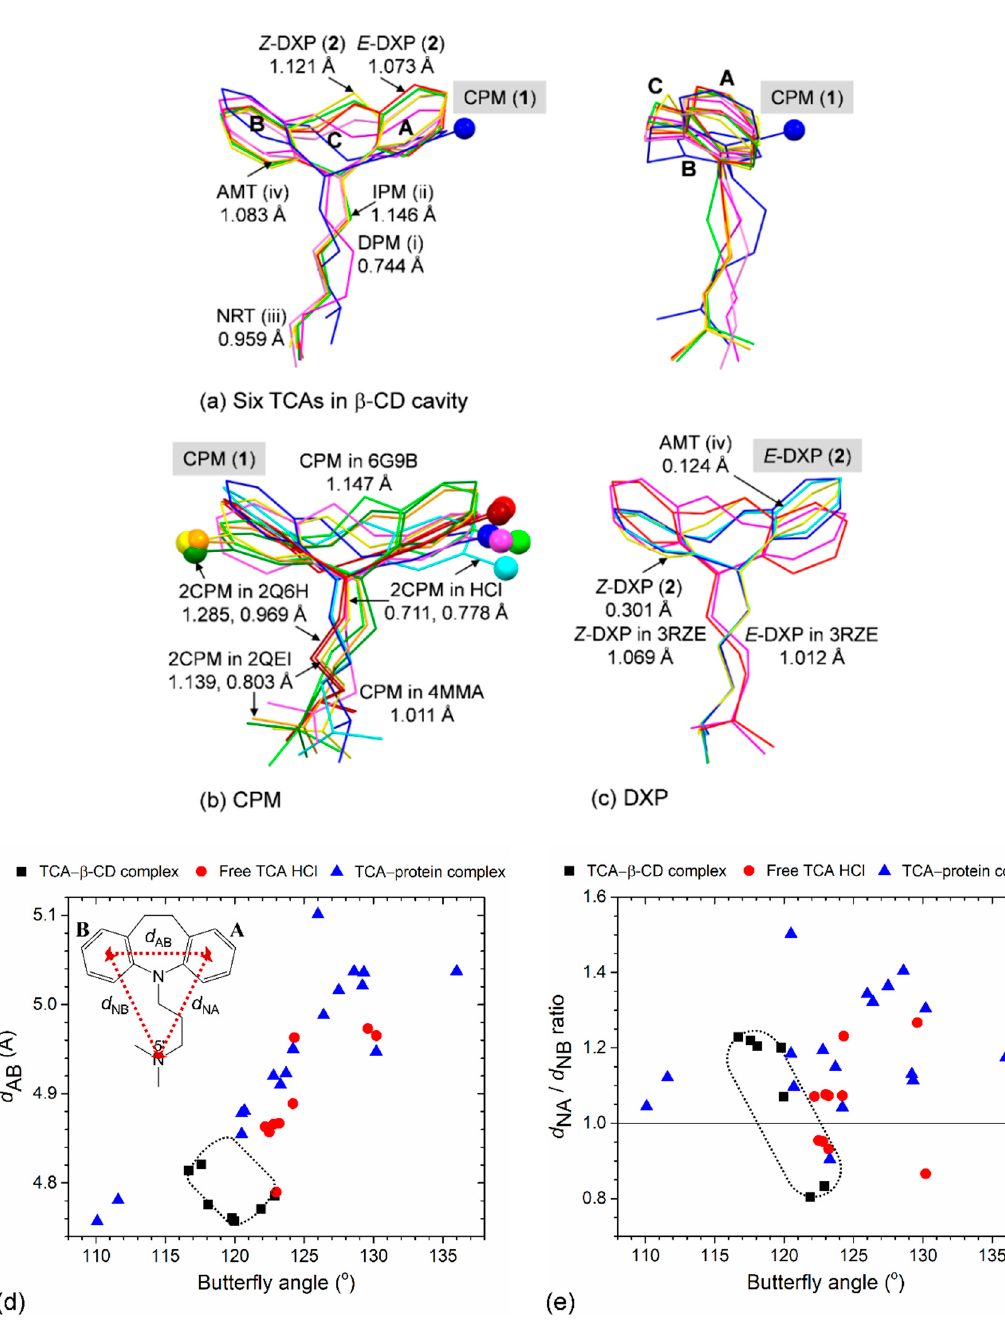
Figure 8. TCA structural flexibility is evidenced by comparison of six TCAs in various lattice environments (viz., TCAs in free HCl form, in β -CD cavity, and in complex with proteins (indicated by the Protein Data Bank (PDB) codes)). Structure overlays of ( a ) six TCAs including CPM ( 1 ), DXP ( 2 ), DPM ( i ), IPM ( ii ), NRT ( iii ), and AMT ( iv ) [14,15] in the β -CD cavity, viewed along the side chain (left) and along the line passing through the B–C–A rings (right), ( b ) CPM, and ( c ) DXP in di ff erent circumstances. Reference structures in ( a – c ) shown in blue sticks and their names marked in gray areas are used for calculating the rms fits; the corresponding value for each structure pair is indicated by nearby distance. The two CPM isomers with Cl group on C3 (A-ring) and C7 (B-ring) are emphasized with ball models. Scatter plots of (d) butterfly angle vs. d AB distance and ( e ) butterfly angle vs. d NA / d NB distance ratio. Data of six β -CD–TCA complexes ( (cid:4) ) are encircled by dotted lines. An example of TCA chemical structure is also given for IPM; see inset of ( d ). For more details, see Table 1 and Table